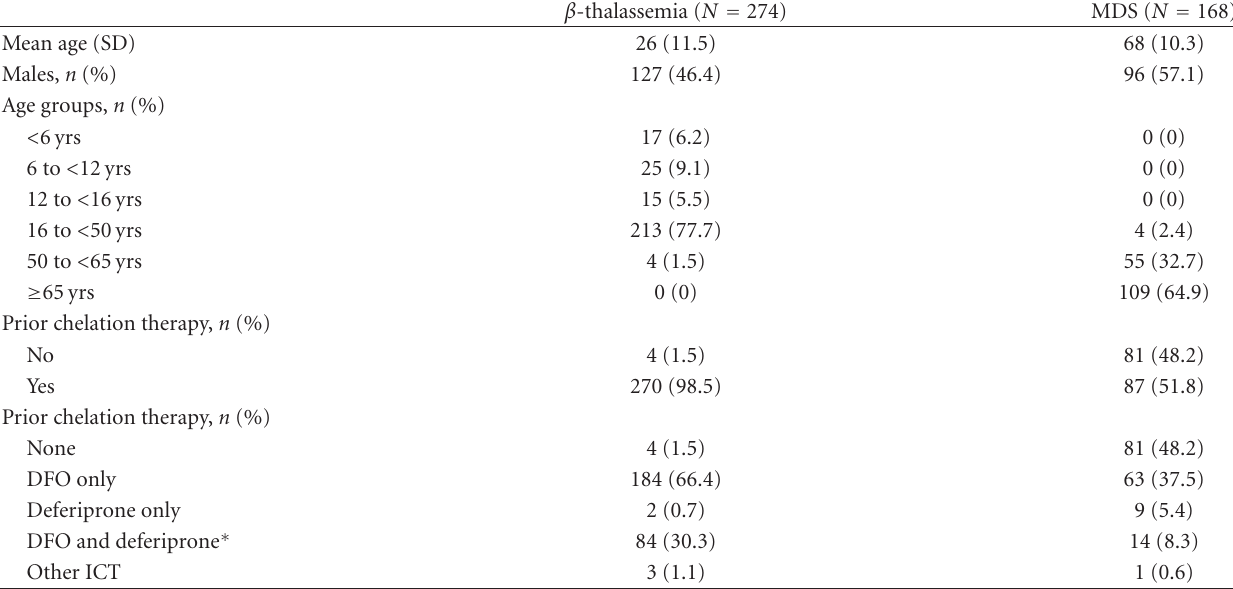
Table 1: Demographic and clinical characteristics of β -thalassemia and MDS patients.